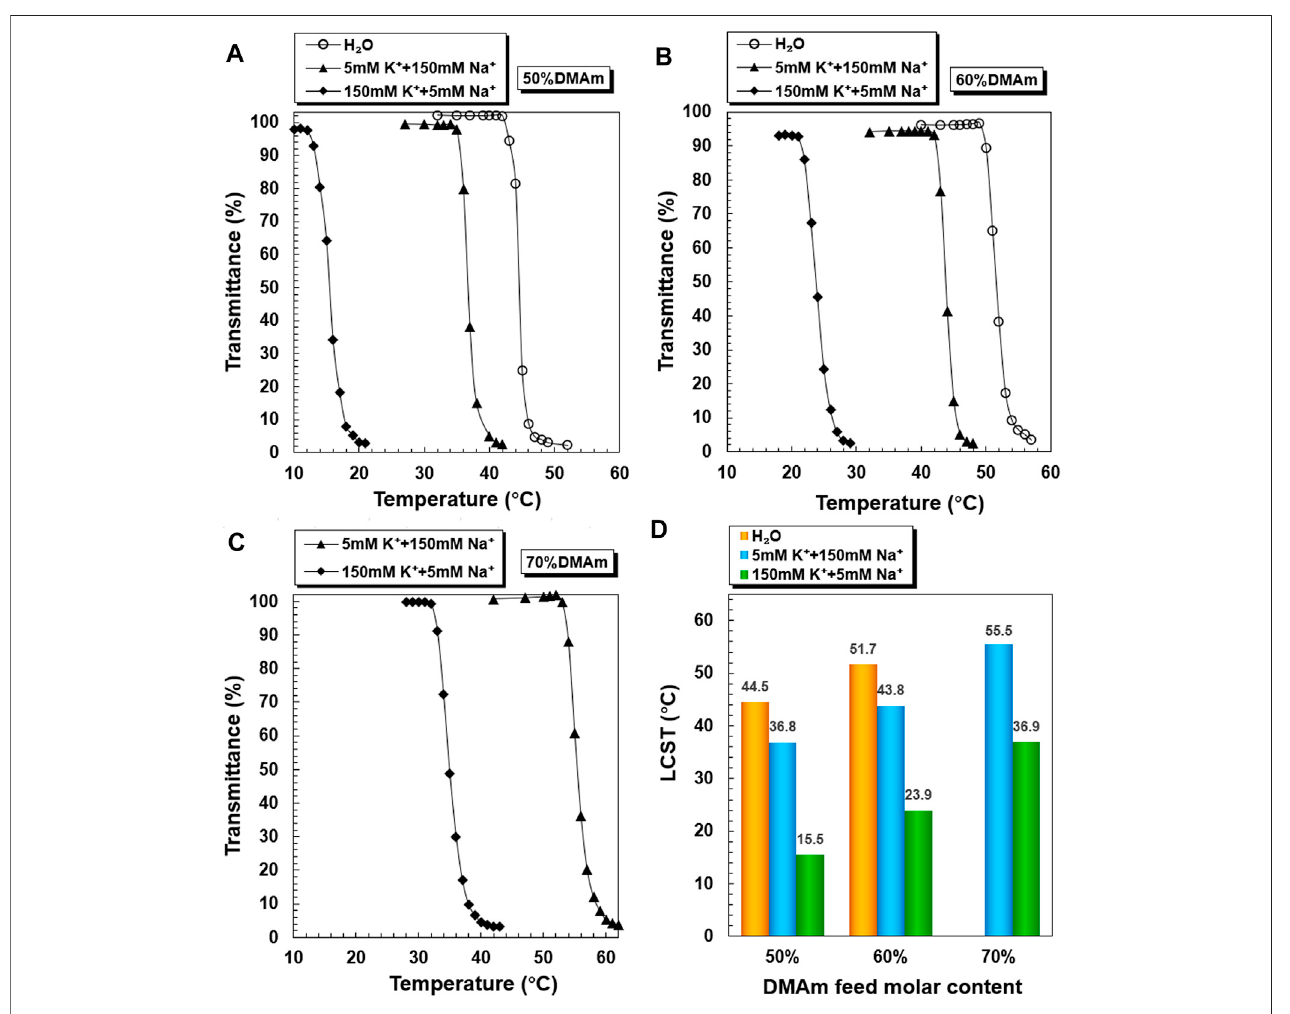
FIGURE 2 | K + -responsive behaviors of PNDB copolymers. Temperature-dependent phase transition behaviors of PNDB1 (A) , PNDB2 (B) , and PNDB3 (C) copolymer solutions with different K + concentration levels. LCST values of PNDB1, PNDB2, and PNDB3 copolymer solutions with different K + concentration levels (D) .